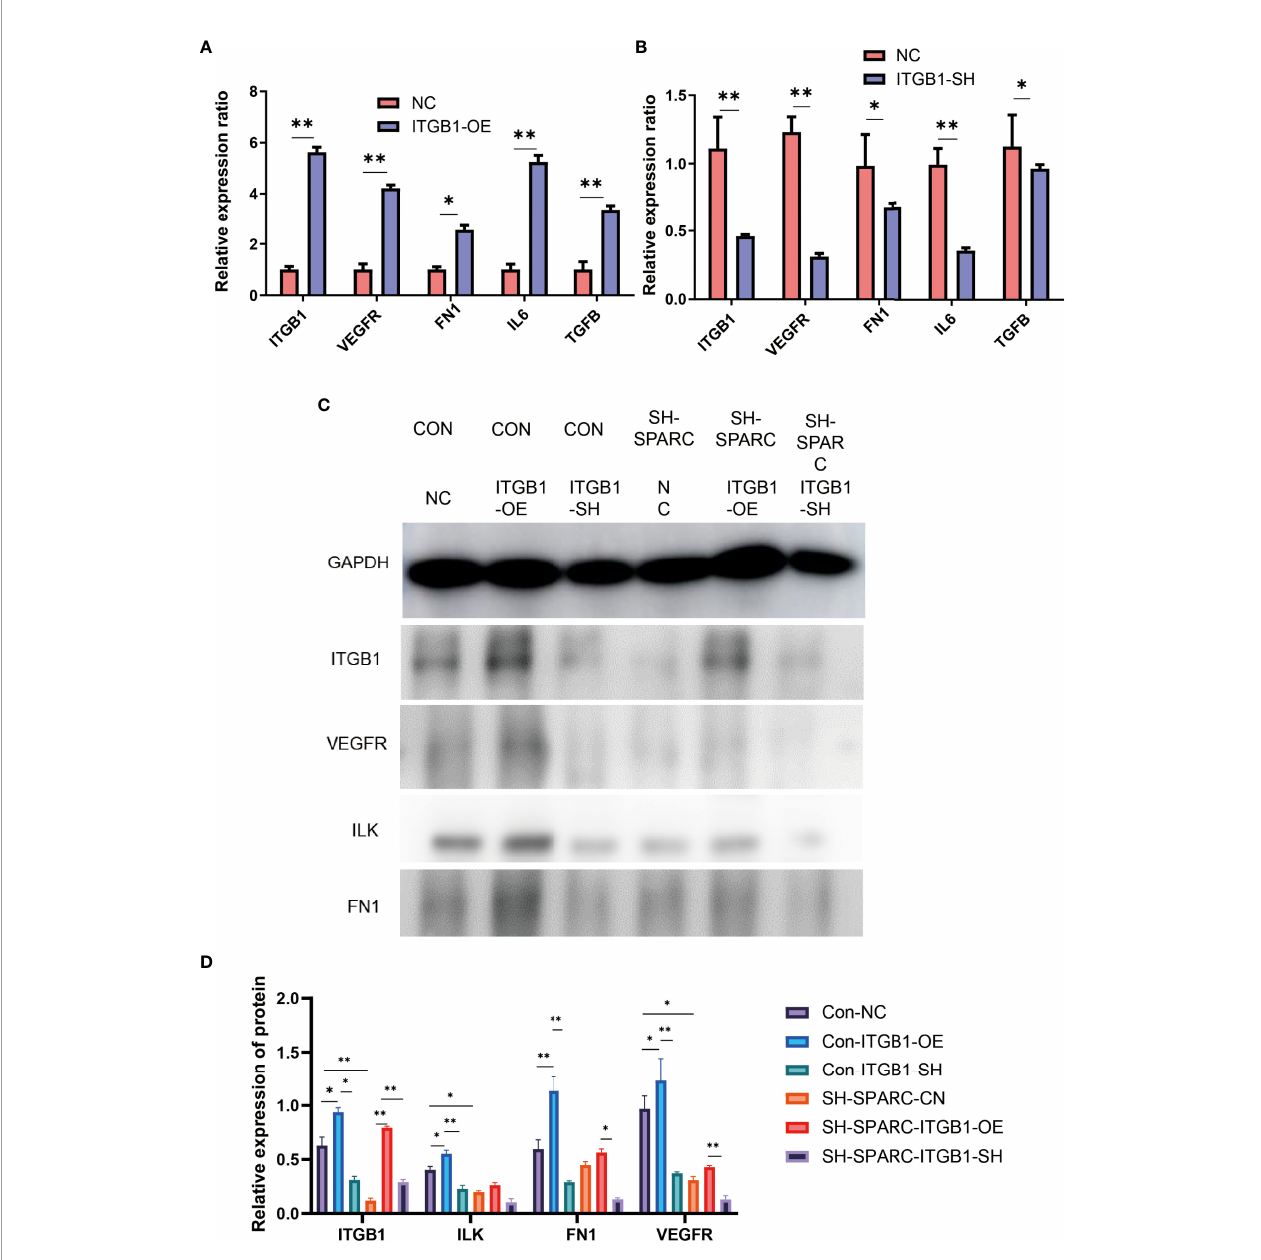
FIGURE 6 | The mRNA and protein levels in overexpression and ablation of ITGB1 experiments. (A) Overexpression of ITGB1 experiments. (B) Ablation of ITGB1 experiments. (C , D) Protein level in the overexpression and ablation of the ITGB1 experiments. *: p < 0.05,**: p <